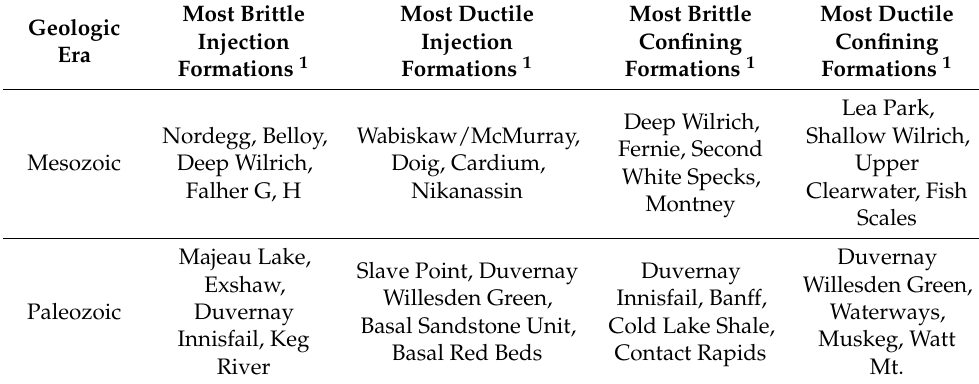
Table 7. Four most brittle and most ductile major injection and confining formations in the Alberta Basin, based on rock mechanical